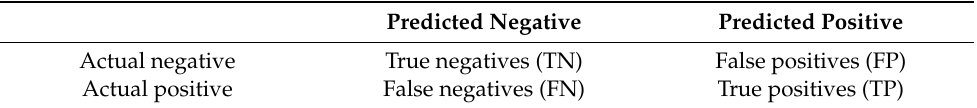
Table 2. Confusion